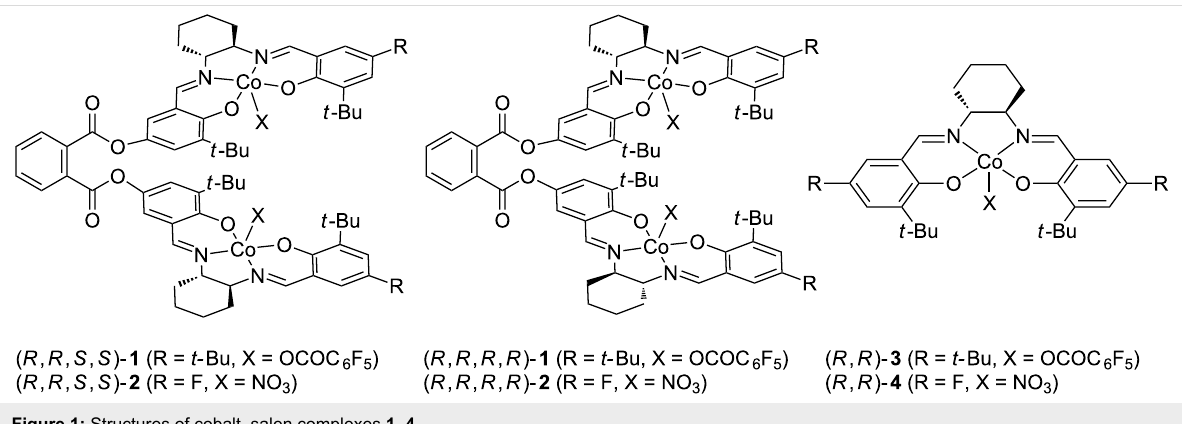
Figure 1: Structures of cobalt–salen complexes 1 – 4